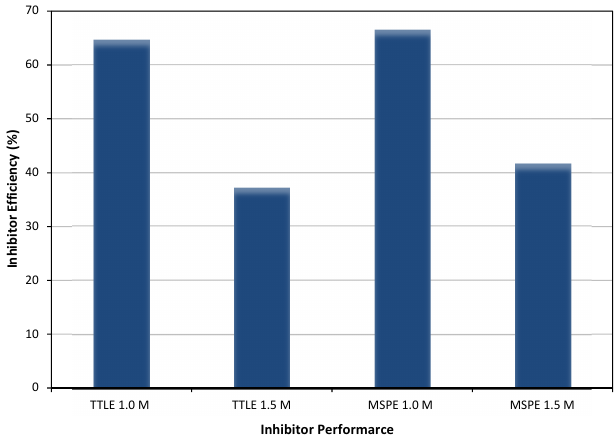
Fig. 6. Average performances of inhibitors at room